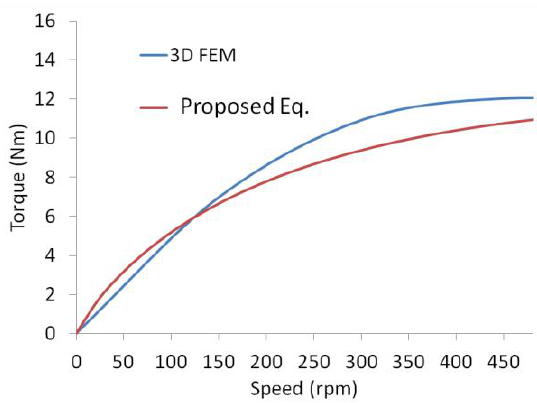
Figure 6. Low-speed skin effect braking torque.